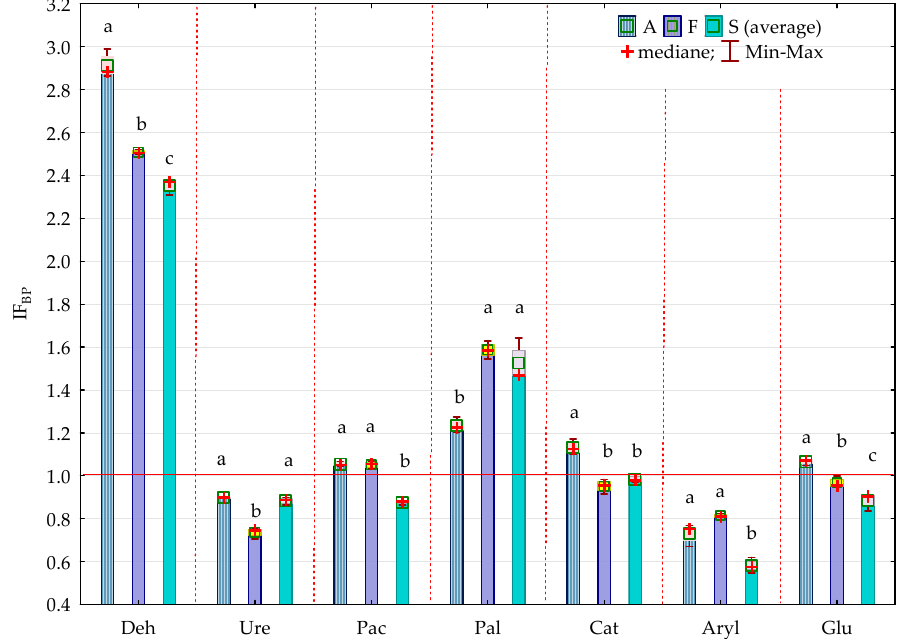
Figure 12. Coefficient of impact (IF BP ) of bisphenols for enzymes activity in soil contaminated with BPA, BPF and BPS in 30th day of research, Homogeneous groups denoted with letters (a–c) were calculated separately for each enzyme, (for abbreviations see Figure 11).